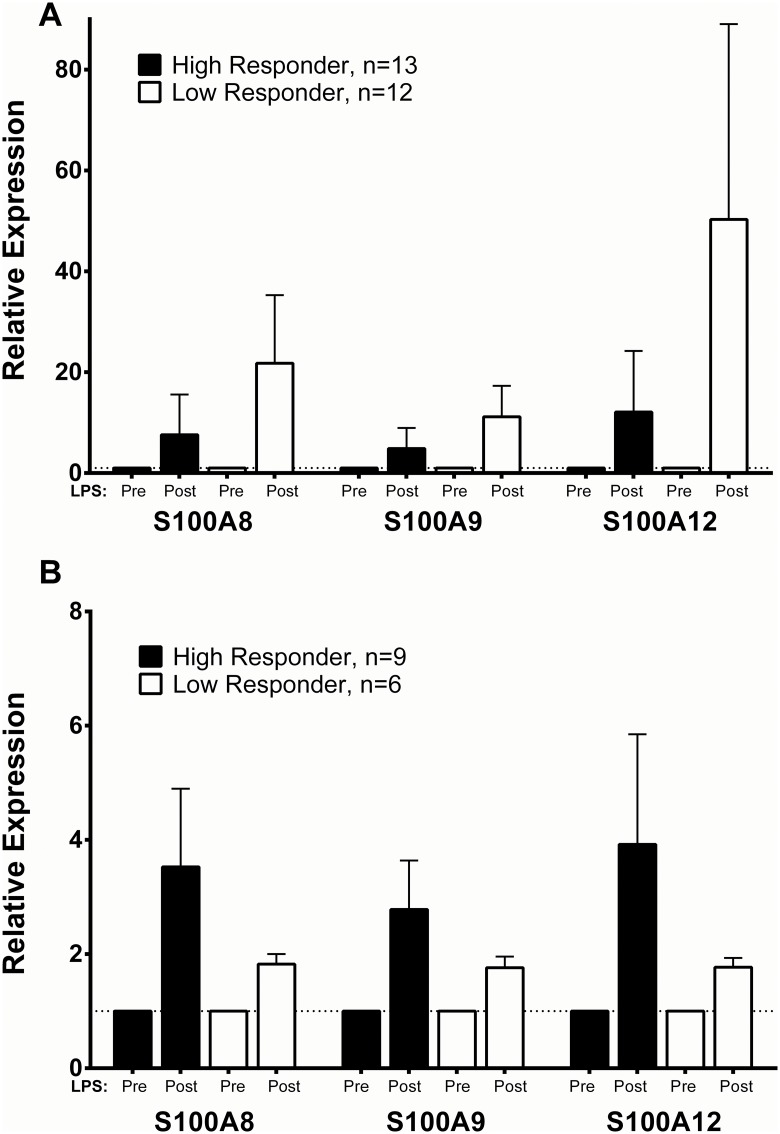
Up-regulation of S100A8, S100A9 and S100A12 in adipose tissue and CD14+ monocytes post-LPS in the GENE Study corresponds to the degree of systemic response to LPS, with a negative relationship in adipose tissue (A) and a positive relationship in CD14+ monocytes (B).Data plotted as mean fold change and standard deviation.